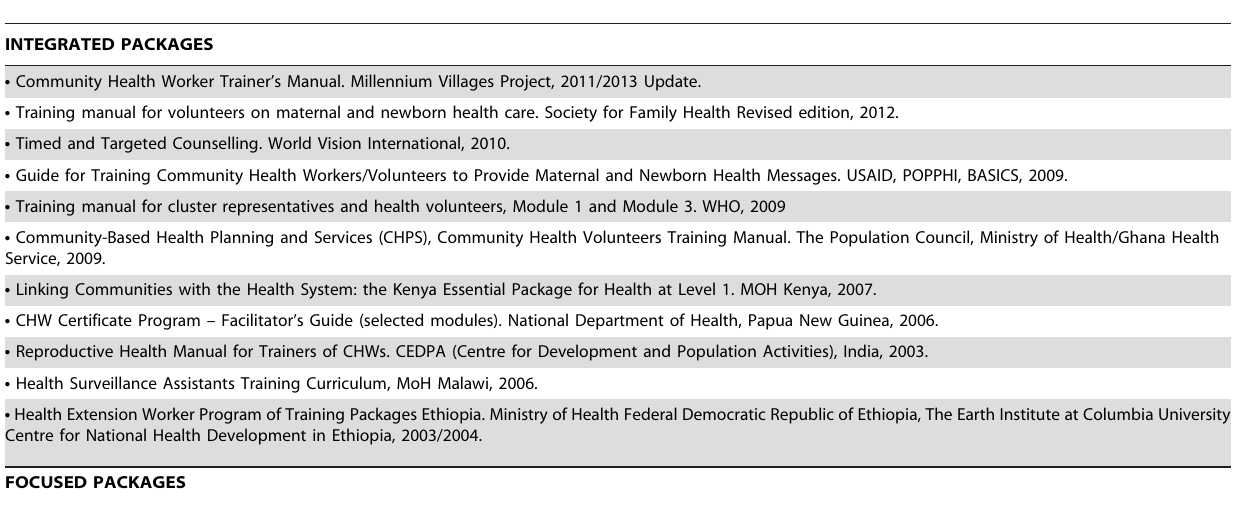
Table 1. Training resource packages on sexual and reproductive health and maternal, newborn, child, and adolescent health.